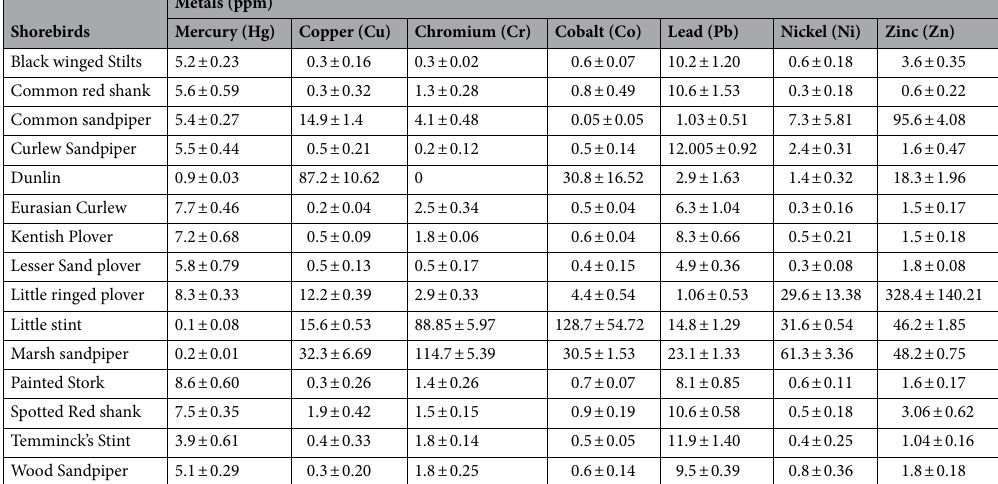
Table 2. Different heavy metal concentration recorded from the feathers of the different shorebird species in Pichavaram Mangrove Forest, Pichavaram, Cuddalore District, Tamil Nadu, India, (Values are Mean ± SE [ppm]).